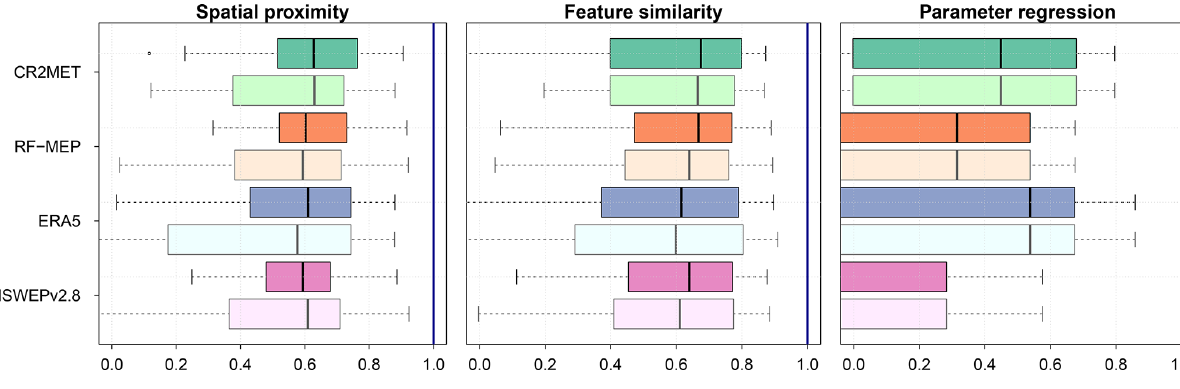
Figure 10. Comparison of regionalisation performance using all catchments as potential donors (dark colours) against the performance when nested catchments are excluded as potential donors (light